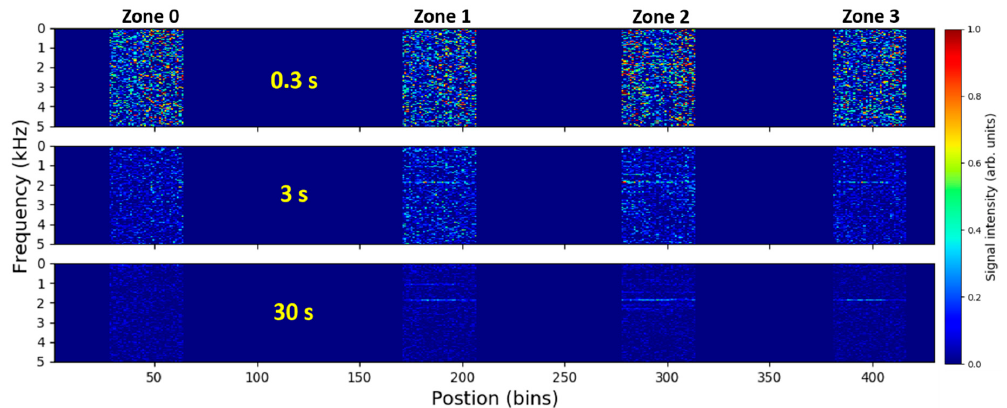
Figure 4. Time-averaged DAS signal spectra along the fiber recorded for 1 mm leak at 5 bars and averaged over different acquisition times. Signals from fiber dead-zones between the monitored pipe zones are discarded, i.e., set to zero. Label acquisition times of 0.3 s, 3 s and 30 s correspond to spectral averaging over 3, 29 and 292 short-time fast Fourier transform (STFFT) windows.